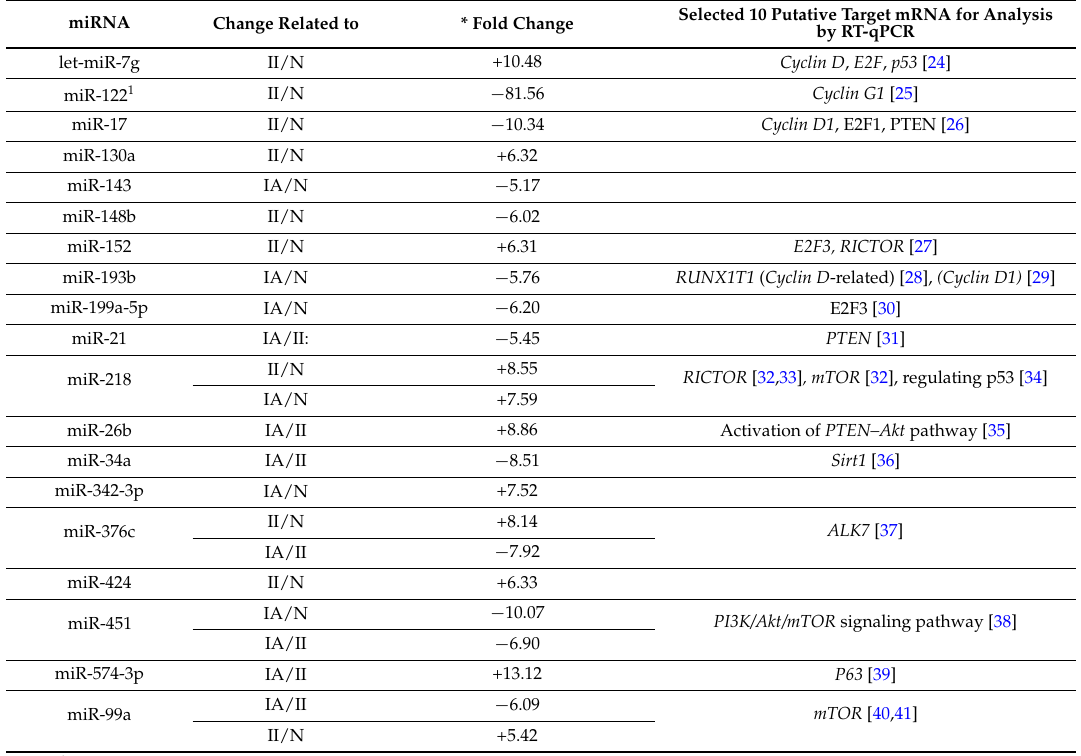
Table 2. Differentially expressed miRNAs based on SOLiD sequencing data. The selection of putative mRNA targets is based on publications in the field of cancer and cell proliferation, not on target prediction tools.